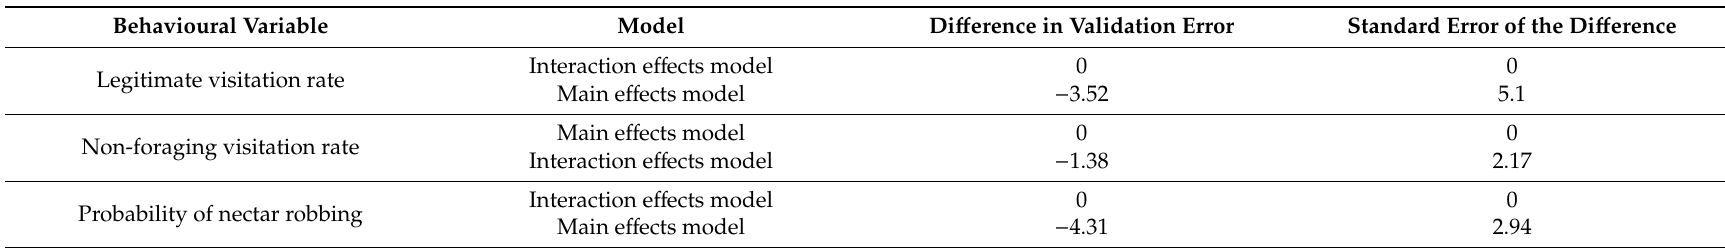
Table 3. The di ff erence in predictive accuracy between the Main e ff ects model (Heat and Insecticide + random e ff ects) and the model including the interaction (Heat × Insecticide + random e ff ects) on Bombus terrestris foraging behaviours. The model with the highest predictive accuracy is ranked as 0 with values showing the di ff erence in validation error and standard error of the di ff erence between models.